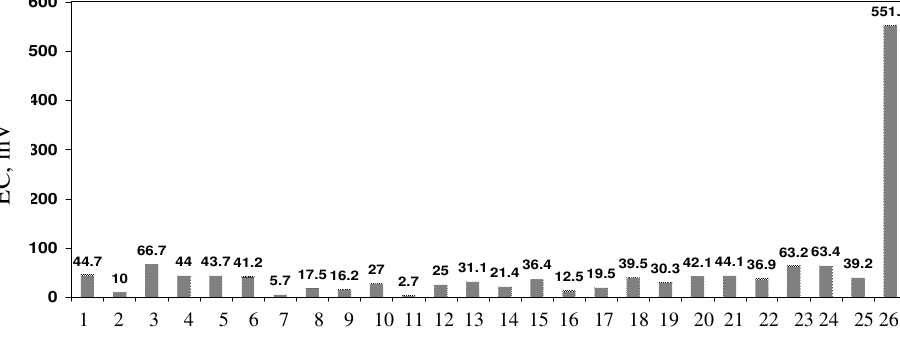
Figure 6. EC values of various water samples collected in and around